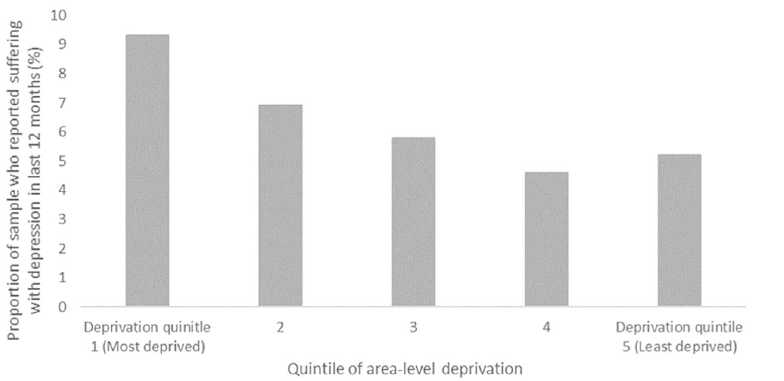
Fig 2. Percentage of respondents with depression, by quintile of area-level